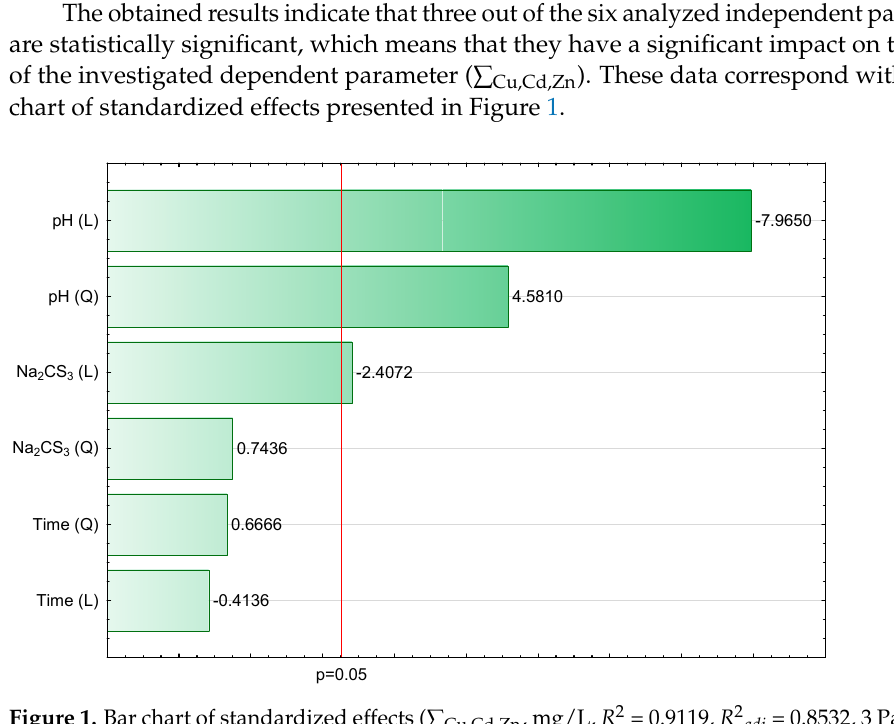
Figure 1. Bar chart of standardized effects ( ∑ Cu,Cd,Zn , mg/L, R 2 = 0.9119, R 2 adj = 0.8532, 3 Parameters, 1 Block, 16 Experiments, MS = 0.1219, L—linear effect, Q—quadratic effect and p —the absolute value of the standardized effect evaluation).